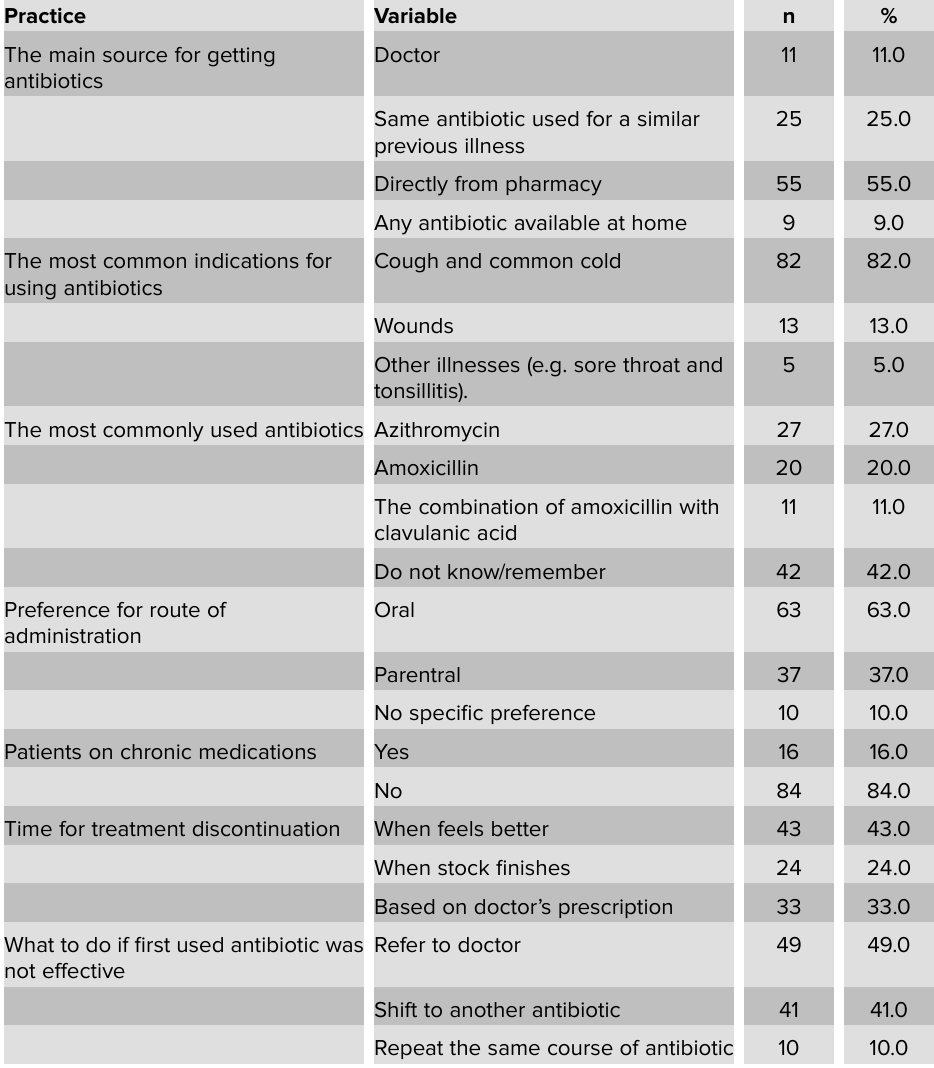
Table 4: The common practices of community participants for antibiotics in River Nile State, Sudan 2014